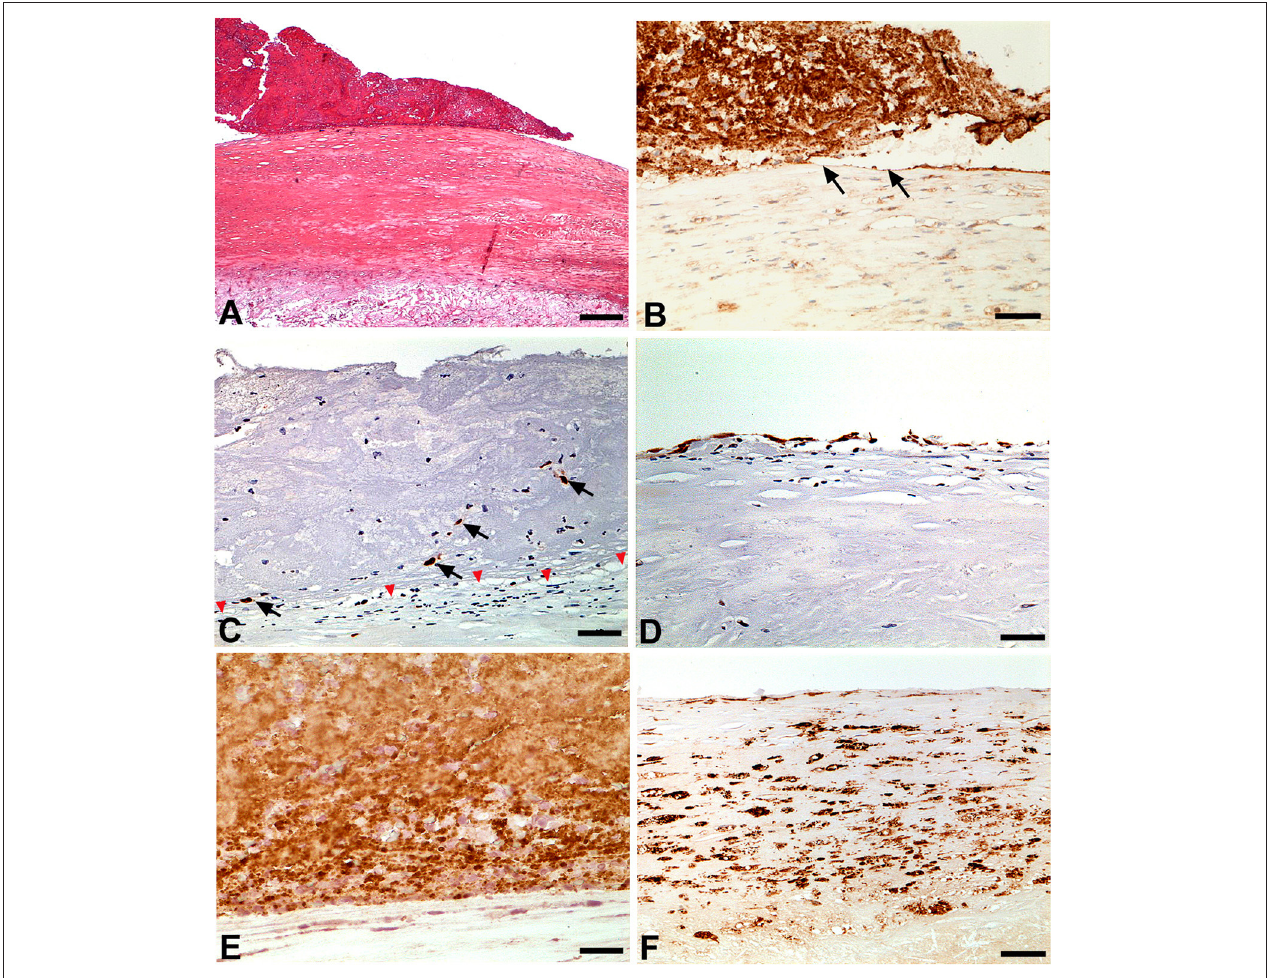
FIGURE 4 | (A) The thrombus is lying on the thick fibrous cap of a fibrolipid plaque without any ulceration. This pattern is consistant with plaque erosion (H&E; Bar = 100 µ m); (B) CD31 labeling shows the loss of endothelial cells below and adjacent to the thrombus (black arrows). The thrombus is also labeled given it includes large amount of platelets (CD31 immunohistochemistry; Bar = 10 µ m); (C) The transcription factor ERG used as an endothelial cell marker shows the complete loss of endothelial cells below the thrombus leaving the intima devoid of endothelial cells (red arrowhead). Note that the thrombus embeds a few detached endothelial cells (arrows) (ERG immunohistochemistry; Bar = 10 µ m); (D) ERG labeling exhibits a continuous endothelial cell layer in areas free of thrombus (ERG immunohistochemistry; Bar = 10 µ m); (E) CD61 labeling shows that the thrombus is rich in platelets (CD61 immunohistochemistry; Bar = 5 µ m); (F) Fibrous